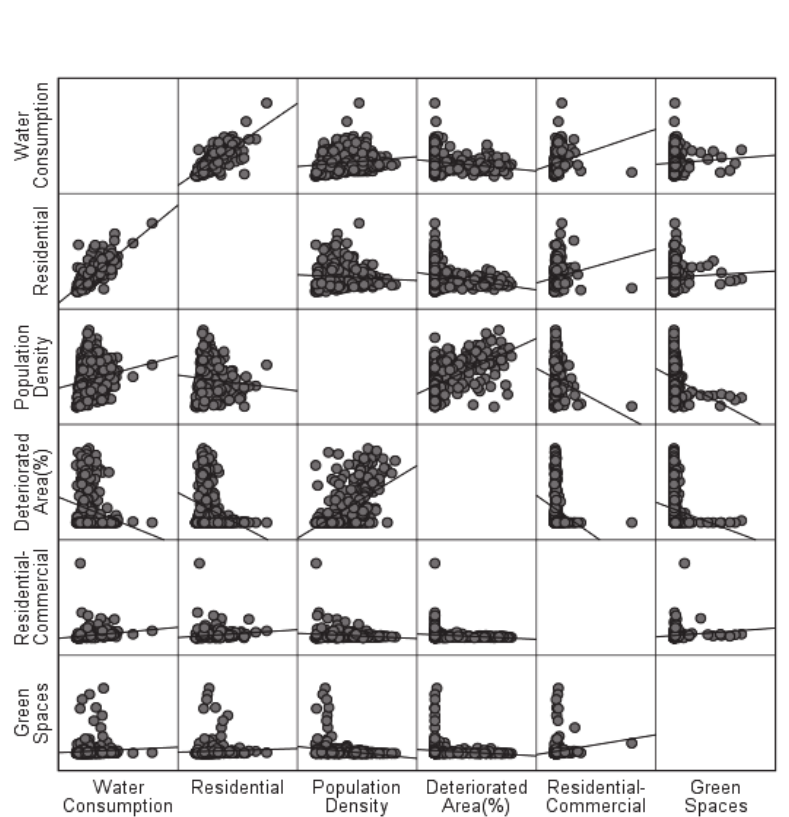
Figure 8. Scatter diagram of significant variables in the regression model regarding water consump- tion: ( a ) cold season; ( b ) warm season; ( c )